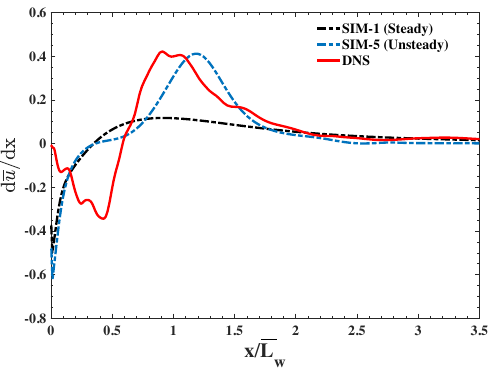
Figure 13. The profile of mean streamwise velocity gradient along the wake centerline. x is normalized by the mean recirculation